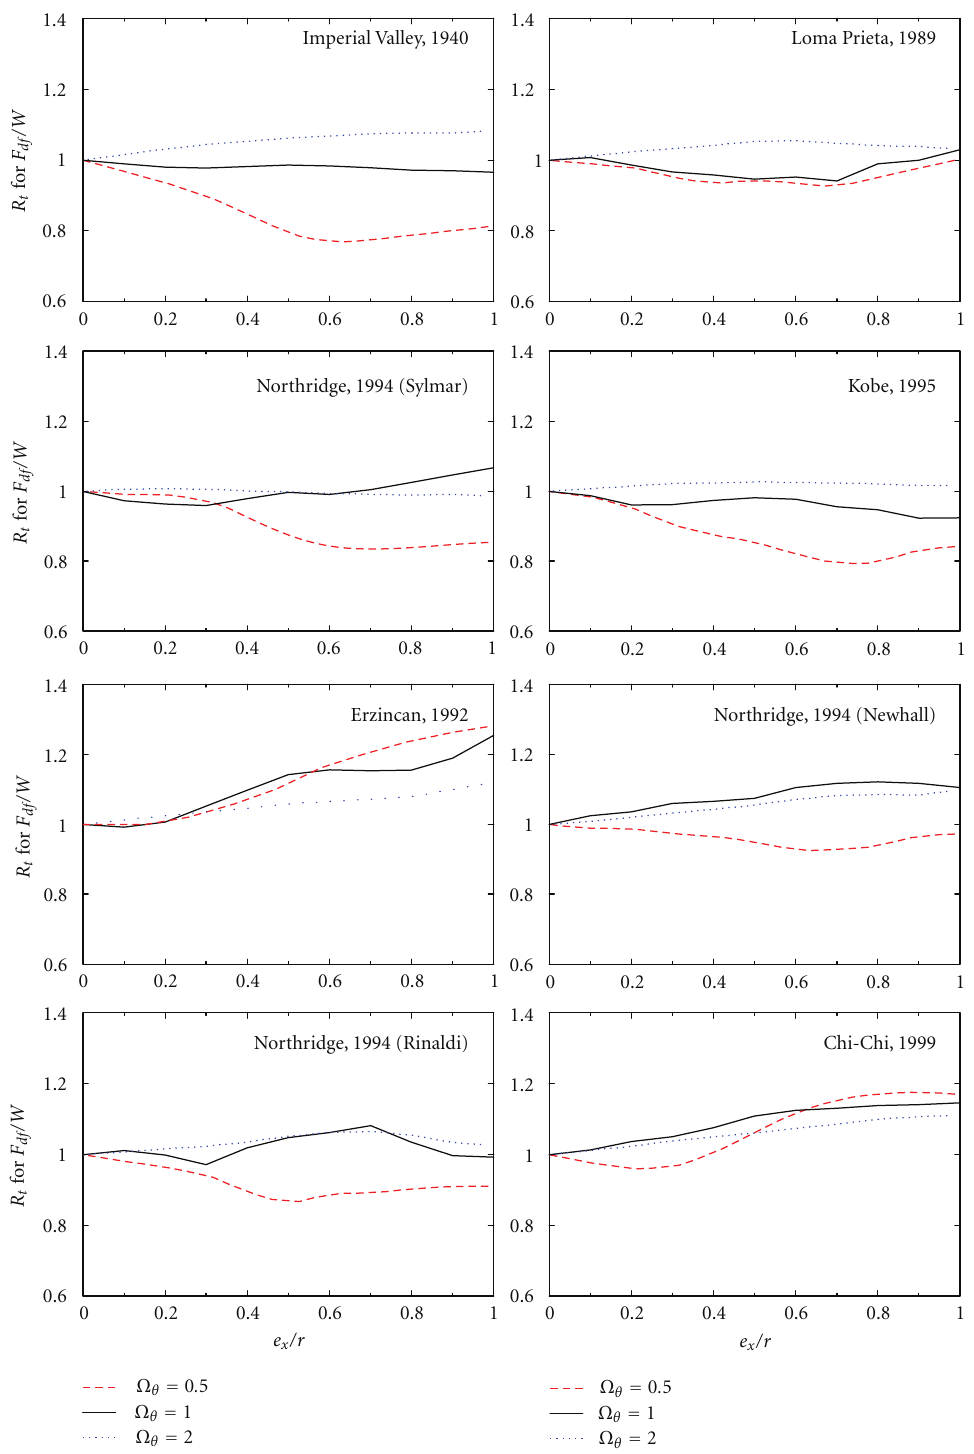
Figure 18: E ff ect of eccentricity on response ratio, R t for normalized flexible edge RMS damper force ( T y = 1 s).